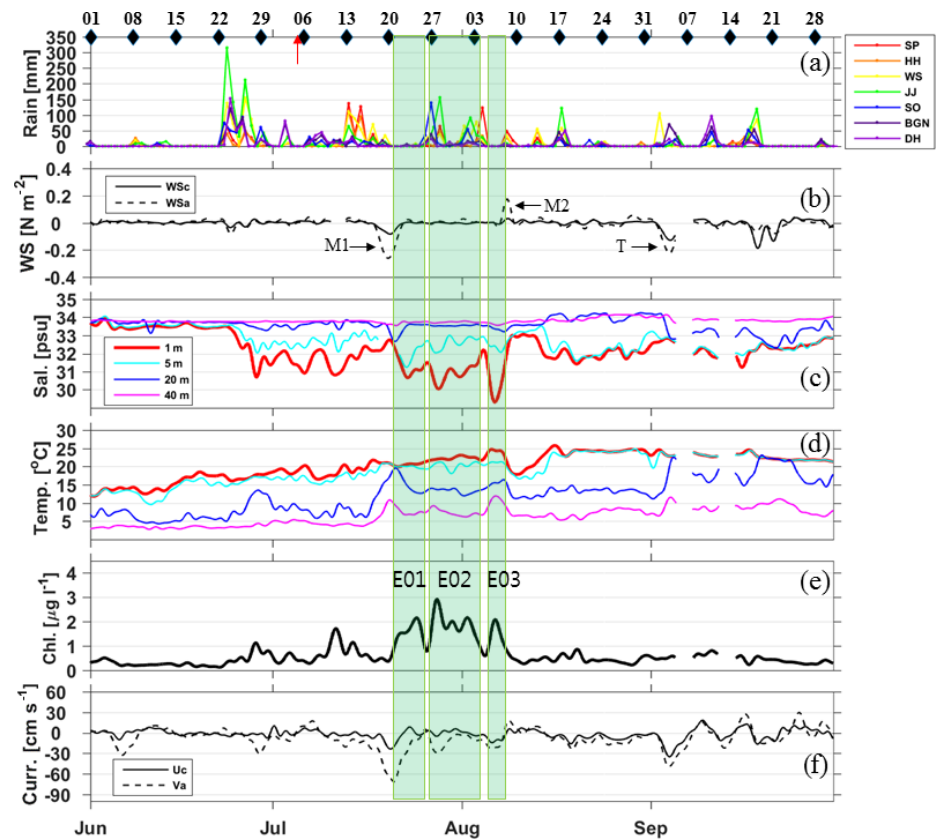
Figure 5. Time-series data collected in 2011 of (a) daily rainfall amounts observed at weather stations (SP: SinPho, HH: HamHeung, WS: WonSan, JJ: JangJun, SO: Sockcho, BGN: BukGangNeung, DH: DongHae) along the east coast of the Korean Peninsula, and (b) alongshore (solid) and cross-shore (dash) wind stresses, (c) salinities and (d) water temperatures observed at the surface (red), 5 (cyan), 20 (blue) and 40m (pink), (e) surface CF and (f) alongshore (dashed) and cross-shore (solid) currents, observed at ESROB. The bloom events are labeled E01 to E03. In the top axis of (a) , dates/times of the satellite-altimetry-derived surface geostrophic current map and geostationary satellite ocean color image (GOCI) are marked with black diamonds and a red arrow, respectively. Nearby passages of typhoons are indicated by black arrows in (b) (M1: Maon, M2: Muifa and T: Talas).